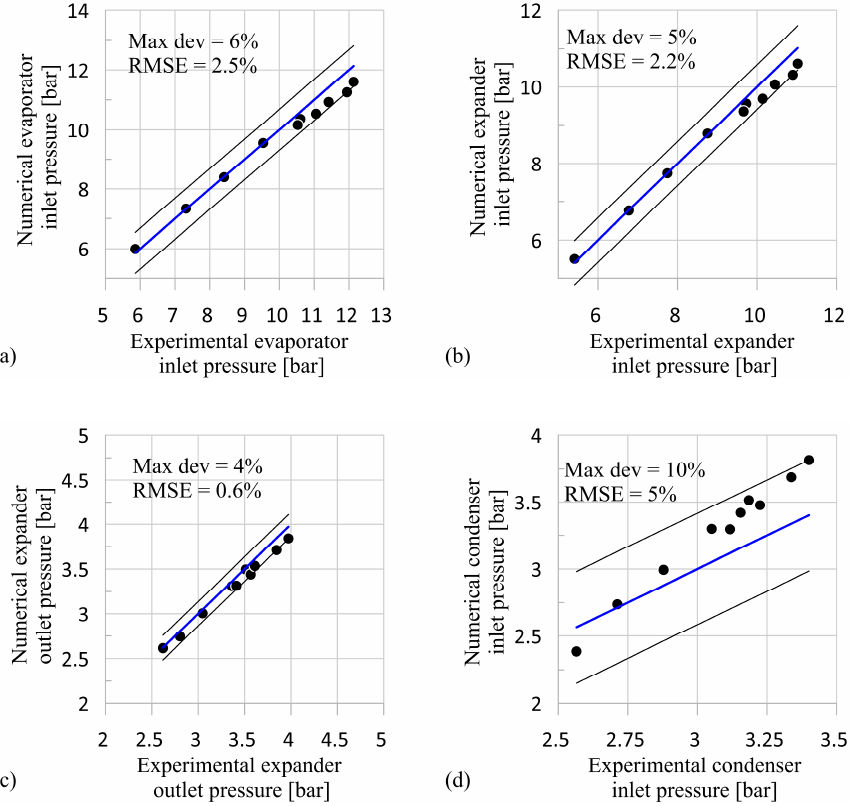
Figure 7. Comparison between the experimental and predicted pressure at the ( a ) evaporator inlet;